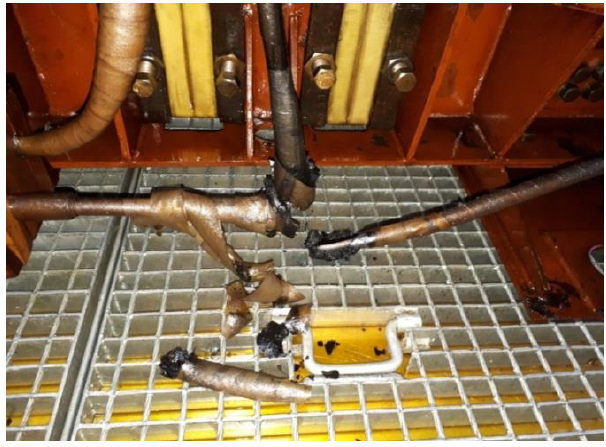
Figure 10. Damage identified during internal inspection of a 10 MVA, 110/6 kV power transformer.